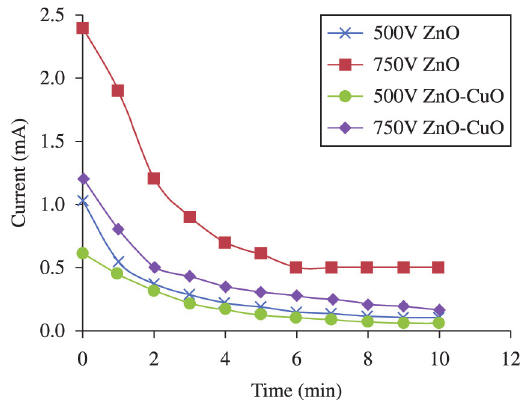
Figure 4. Current behaviour during electrophoretic deposition.